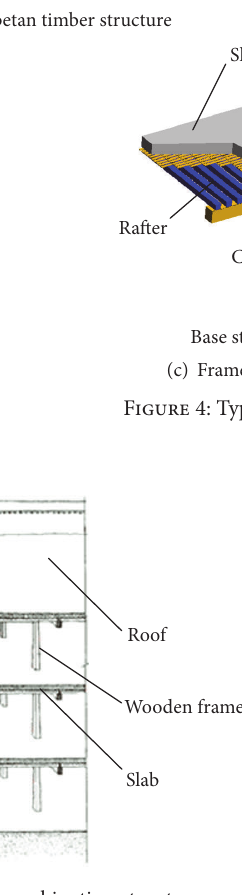
Figure 5: Rigid-flexible combination